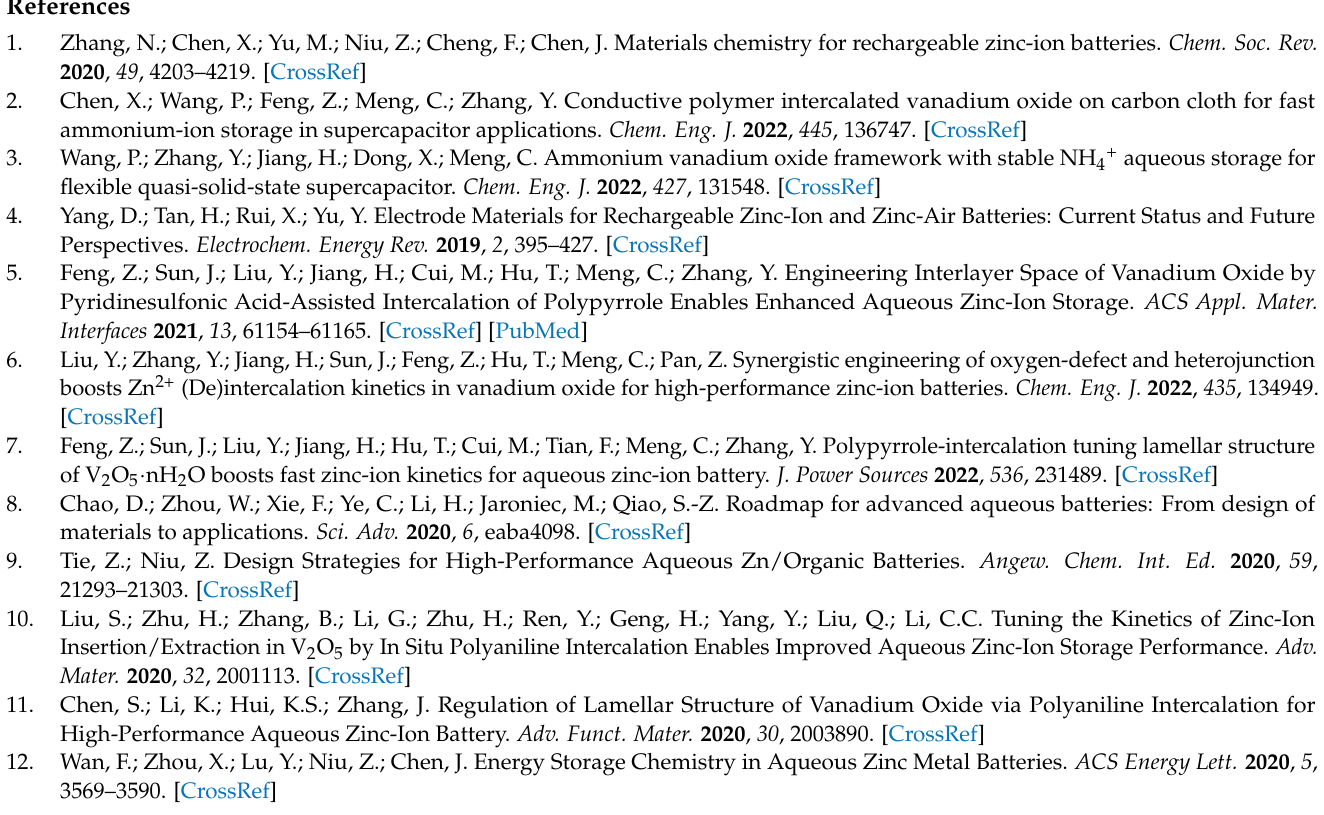
and electrochemical characterizations. Figure S1: SEM images of ZnVOH. Figure S2: A SEM image of ZnVOH/rGO for collecting elemental mapping images. Figure S3: (a) Cycle performance and (b) GCD curves at 4 A · g − 1 of ZnVOH and ZnVOH/rGO. Table S1: Atomic ratio of Zn and V in ZnVOH by ICP analysis. Table S2: Atomic ratio of Zn and V in ZnVOH/rGO by ICP analysis. Table S3: Comparison of the specific capacities between the previously reported cathode materials for AZIBs and this work